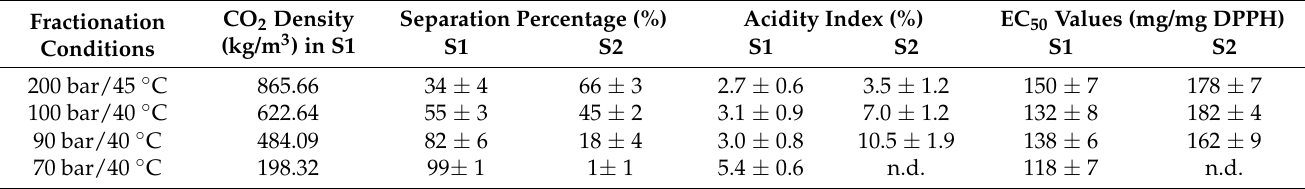
Table 2. Properties of the extracts obtained by cascade fractionation (S1: separator 1 and S2: separator 2). Data are represented as the mean with the 95% confidence